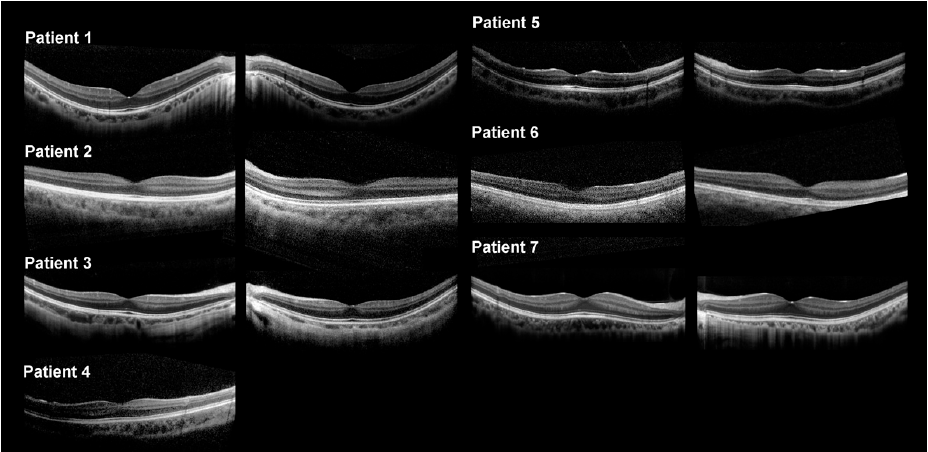
Figure 3. Spectral domain optical coherence tomography (SD-OCT) imaging. Each number corre- sponds to the patient number, with the right eye first followed by the left eye. Patient 1 had an intact ellipsoid (EZ) line and thin choroid in both eyes. Patient 2 had intact inner and outer segment lines. Patient 3 had intact EZ lines and a normal retinal architecture in both eyes. Patient 4 had an intact EZ line in the right eye, and SD-OCT in the left eye showed no obvious defect in the anatomical structure except for a thinner retina. Patient 5 had a normal SD-OCT. Patient 6 had an overall thin retina. Patient 7 had dome-shaped macula in his right eye, and an intact EZ line in both his eyes.